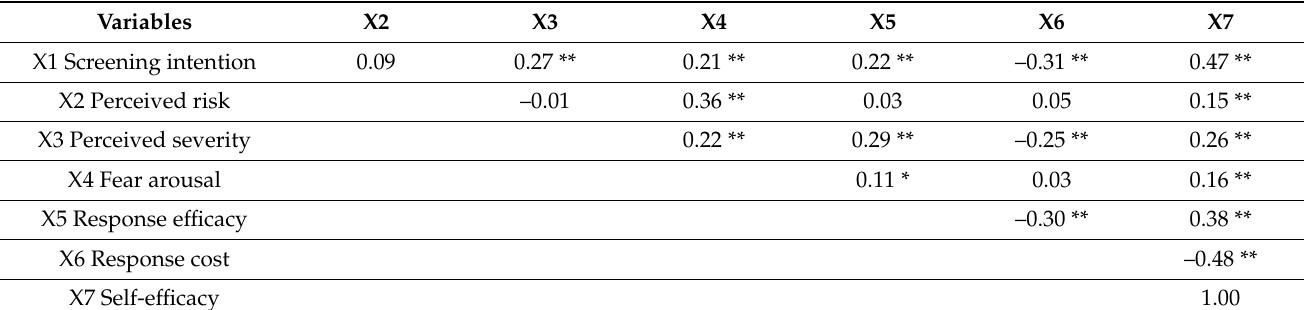
Table 3. Correlations of breast cancer screening intention with PMT